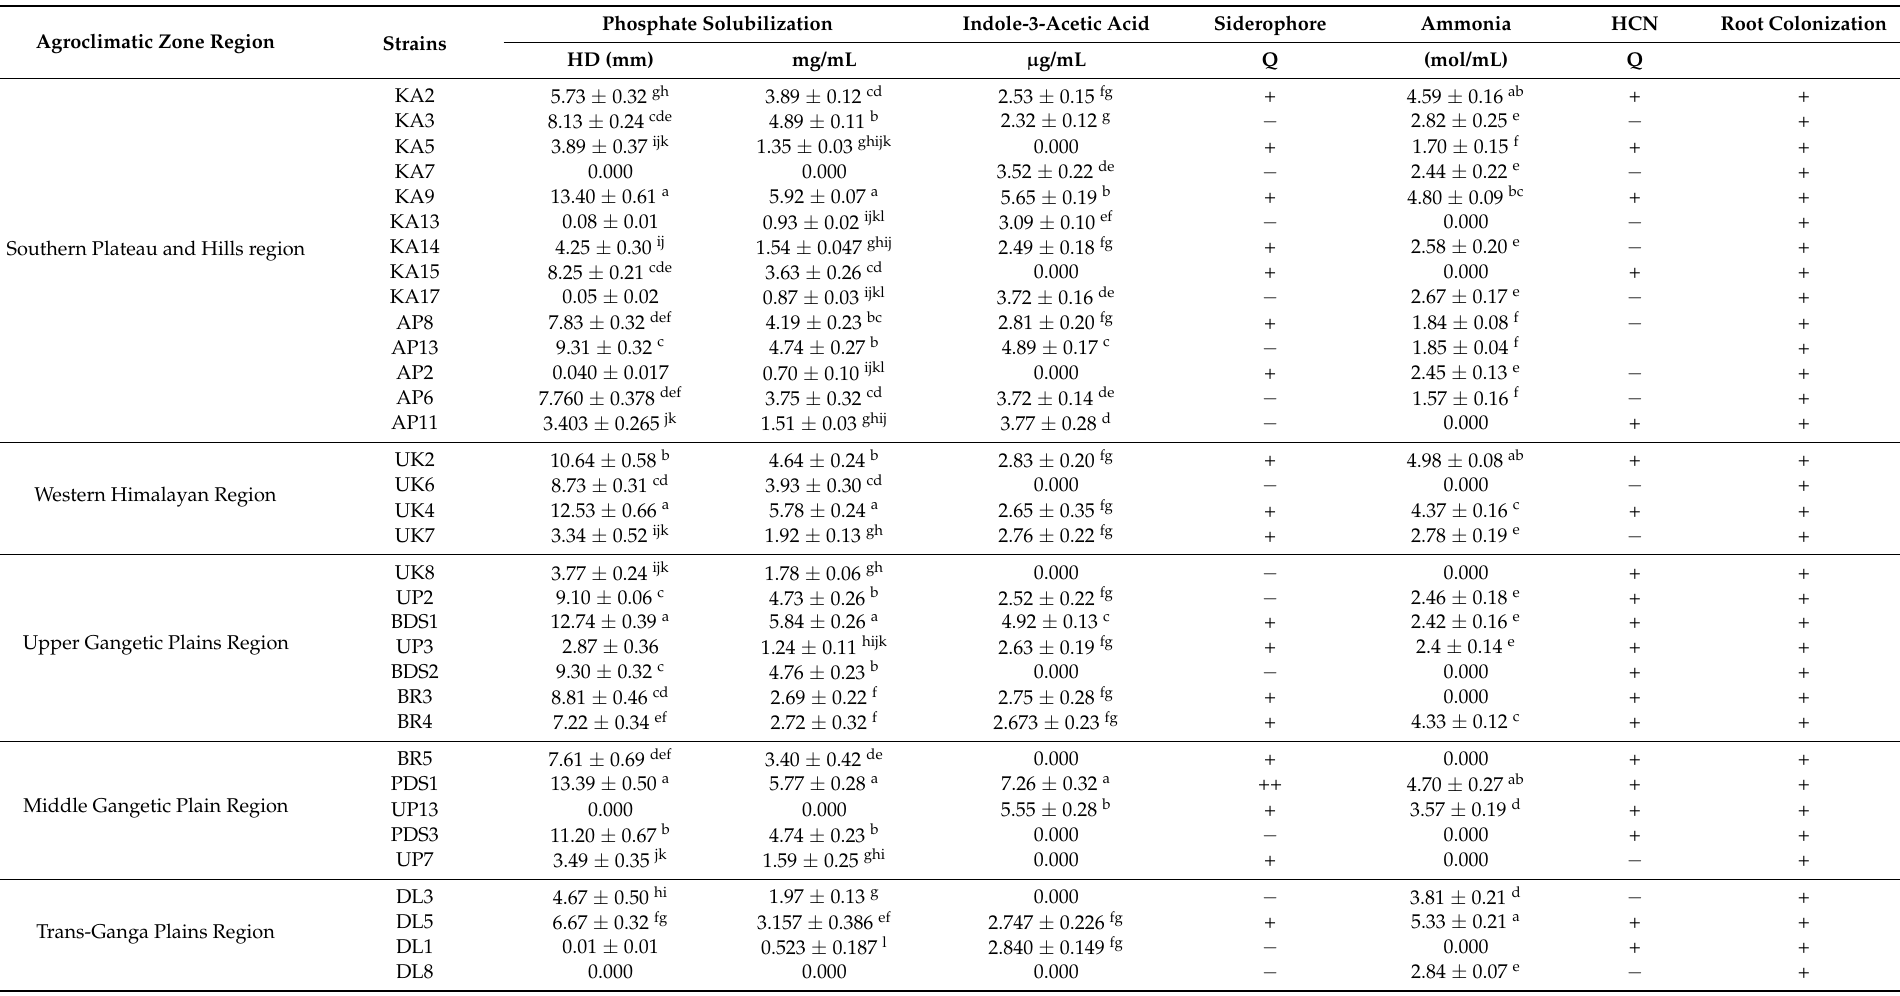
Table 2. Biochemical analysis of rhizospheric bacteria isolated from chilli rhizosphere collected from different agroclimatic